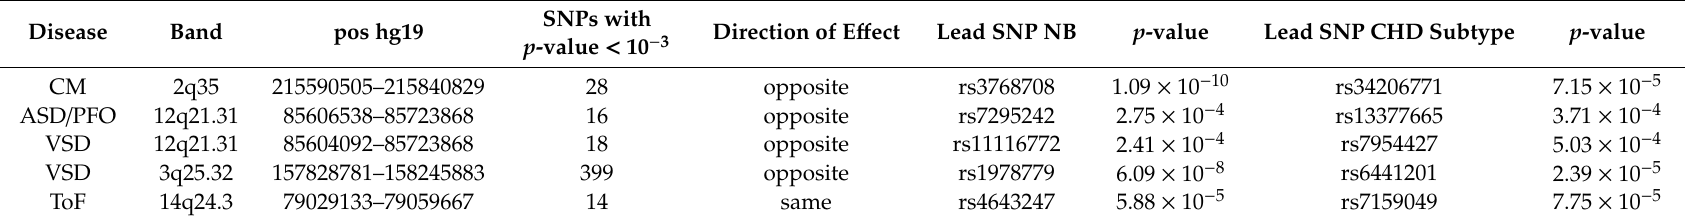
Table 3. Shared association regions between neuroblastoma and the diverse CHD subtypes.